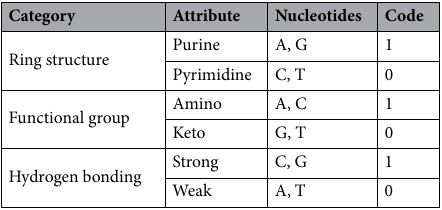
Table 1. Nucleotide categorical attribute-wise encoding.